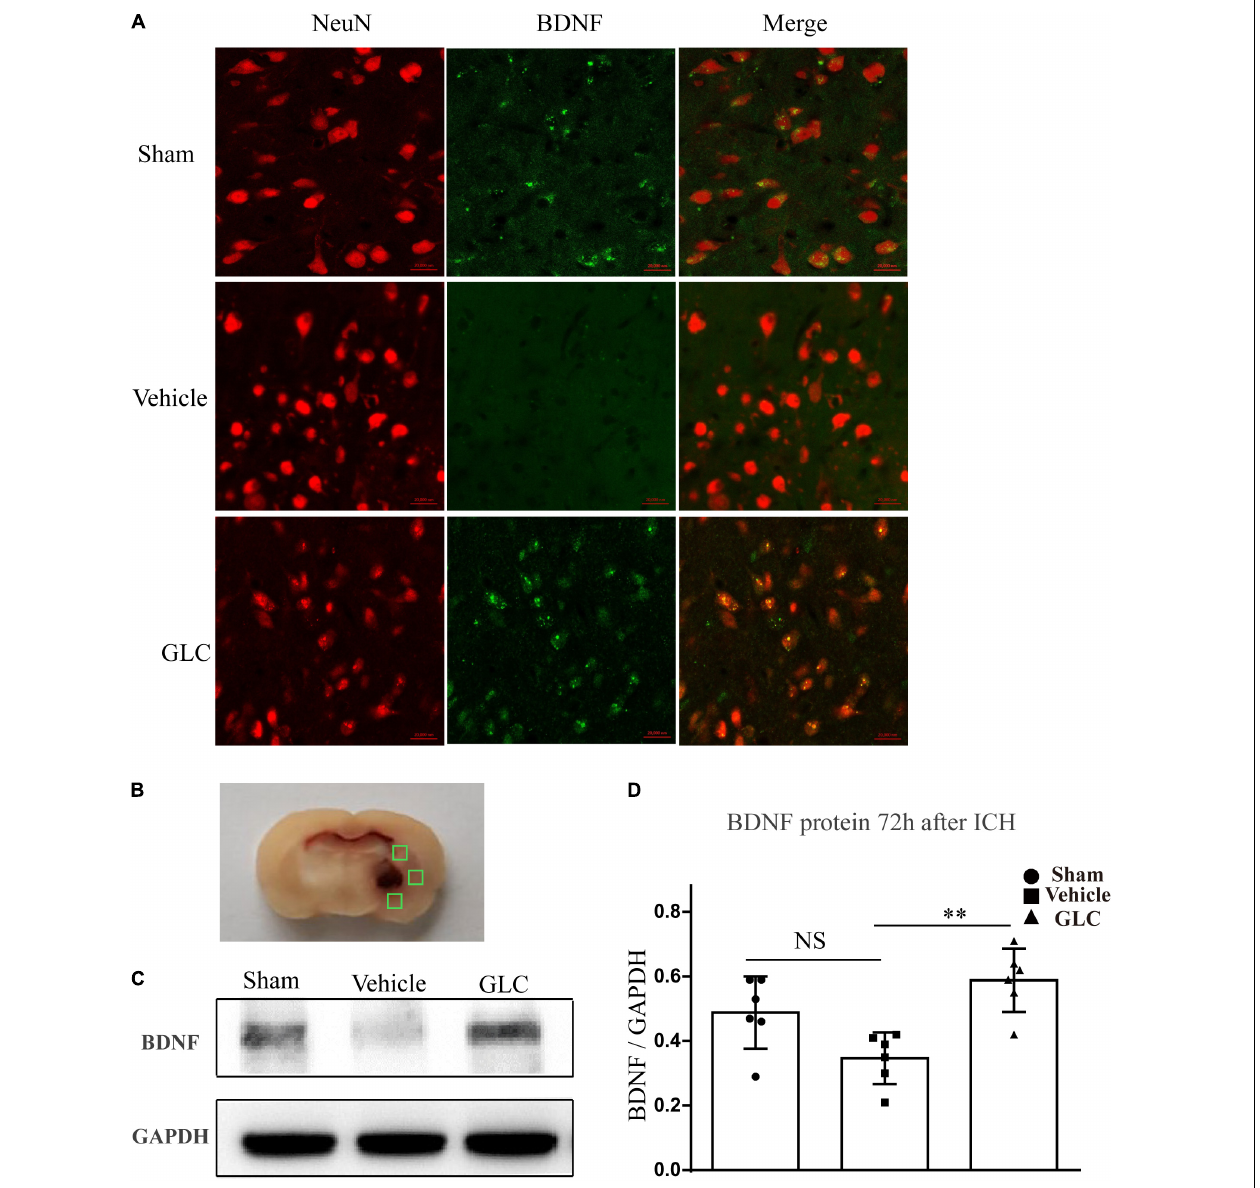
FIGURE 4 | Glibenclamide treatment significantly increased the expression of brain-derived neurotrophic factor (BDNF). (A) BDNF upregulation was observed in neuron cells surrounding the hematoma (six rats/group). Bar = 20 µ m. (B) Studied regions were marked with “ (cid:3) ”. (C,D) The results of the mean band densities are presented as the mean ± SD, ∗∗ p <